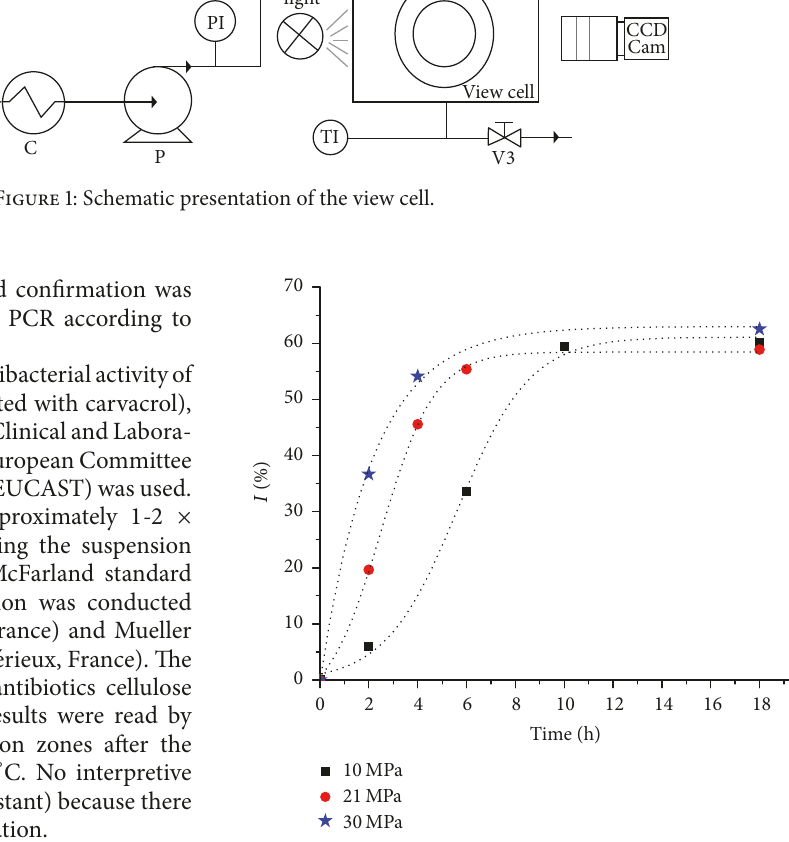
Figure 2: Change in carvacrol impregnation yield with time (the lines are drawn to guide the